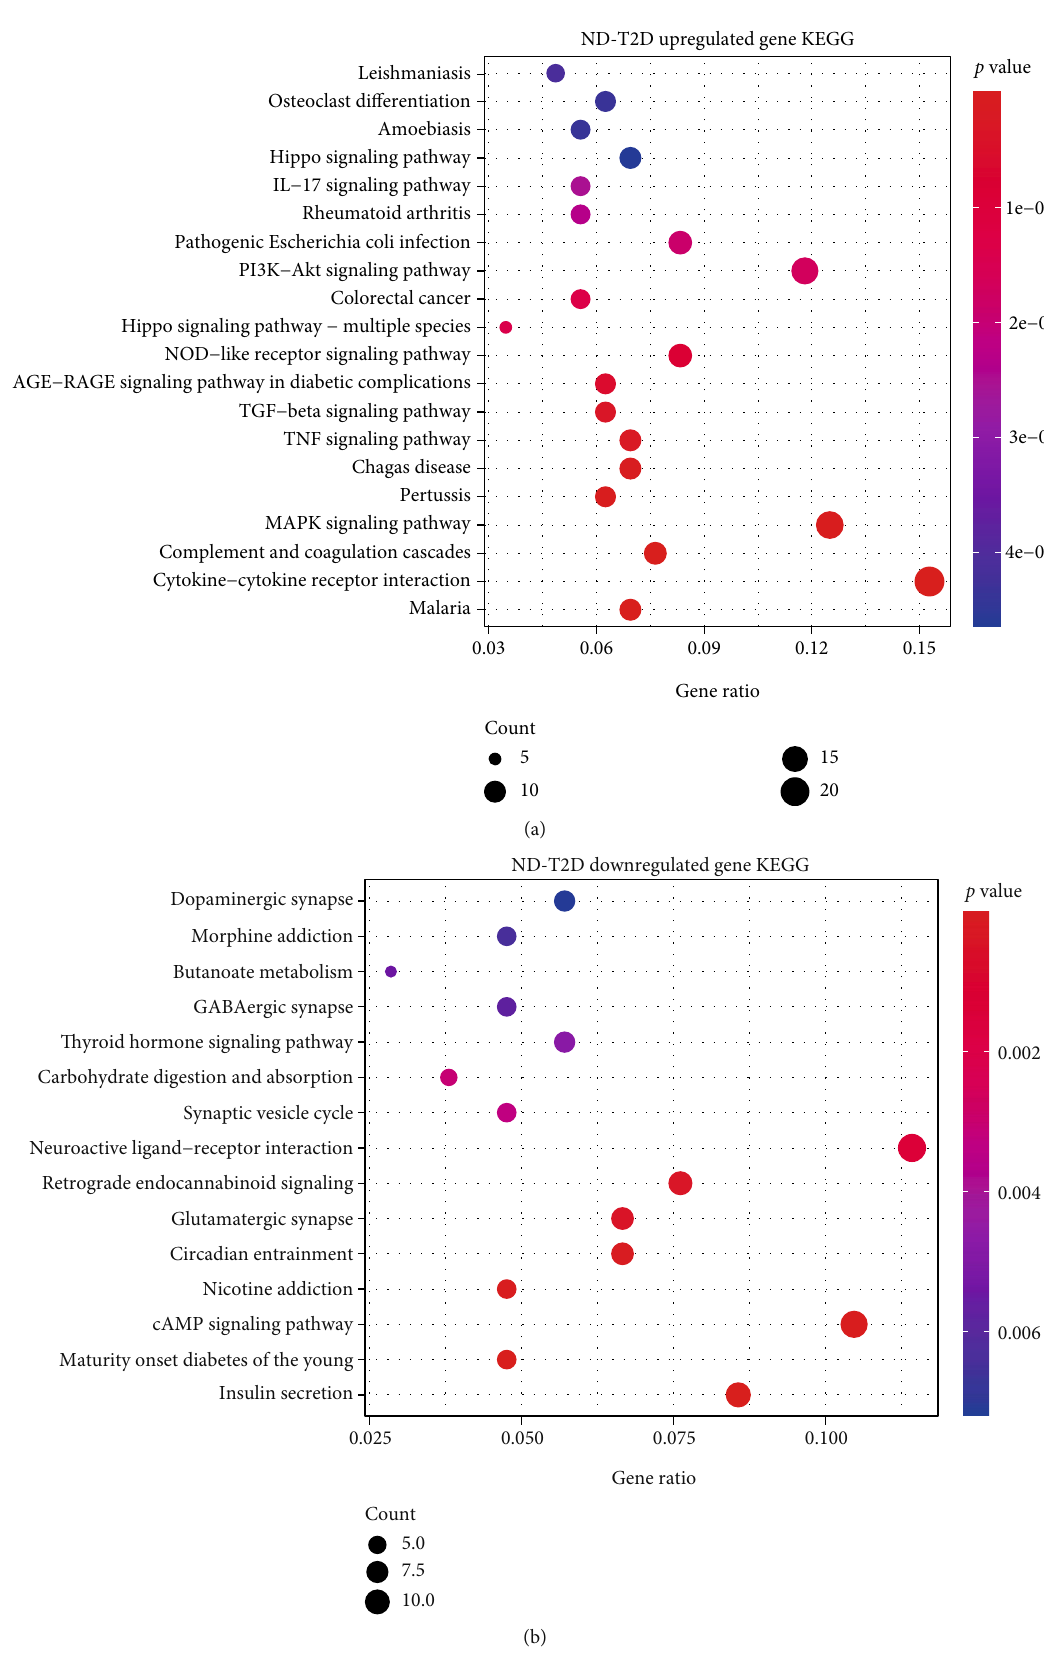
Figure 5: KEGG analysis of the up/downregulated DEGs involved in